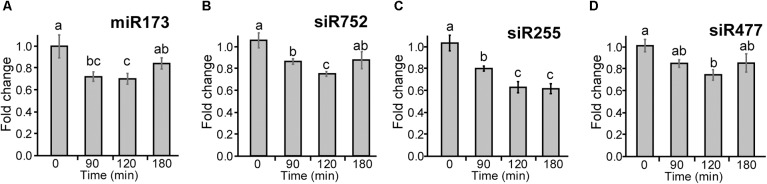
Cold-induced reduction of miR173 and TAS1a-derived siRNAs. Small RNA gel blot analysis was performed using RNA from rosette leaves harvested at different time-points after application of cold. Samples were hybridized with radioactively labeled probes specific to miR173 and the different siRNAs and bands were quantified. (A) miR173, (B) siR752, (C) siR255, and (D) siR477. The temperature at the different time-points was 20°C (0 min), 5°C (90 min), and 4°C (120 and 180 min). The letters on the bars indicate significantly different expression levels of small RNAs using Student’s t-test (p < 0.05); different letters mean significant differences between the samples.